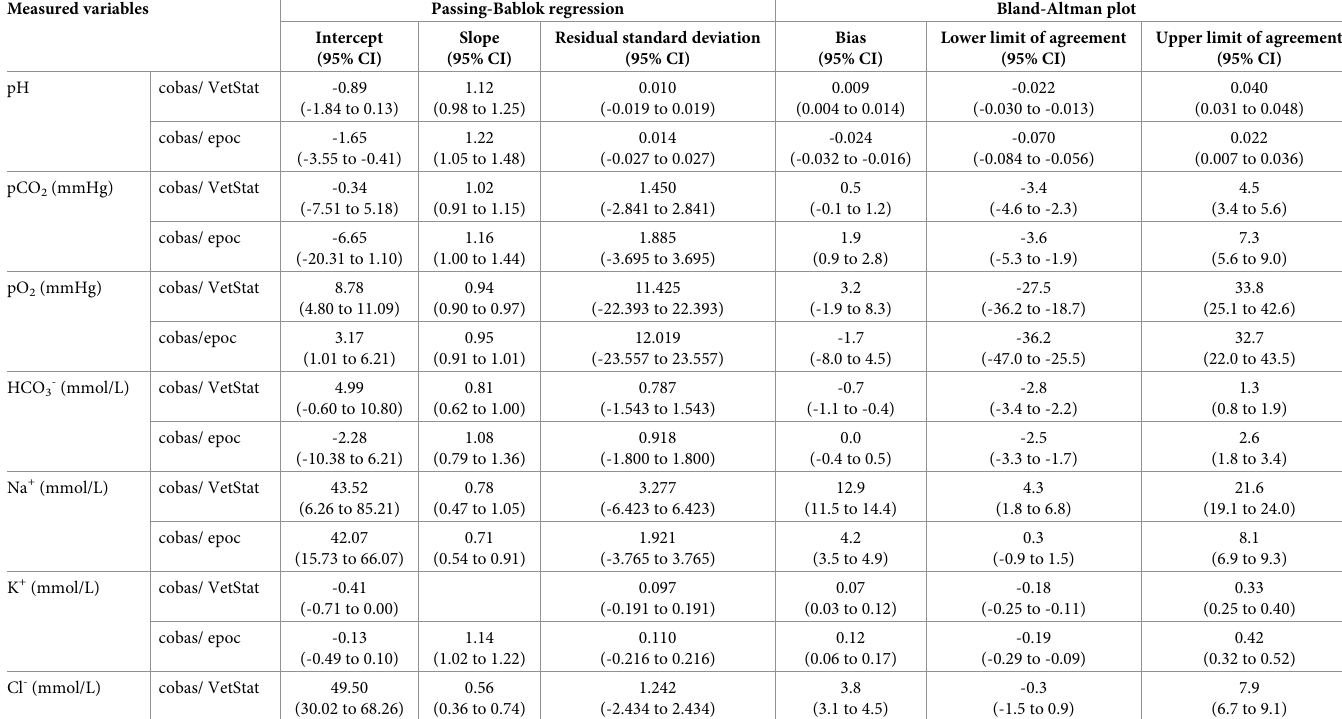
Table 2. Intercept, slope and residual standard deviation of Passing-Bablok regression as well as bias, lower and upper limit of agreement from the Bland-Altman plots and their 95% confidence intervals (95% CI) from the comparisons between the cobas b 123 and VetStat and the cobas b 123 and epoc analyzers. Measured